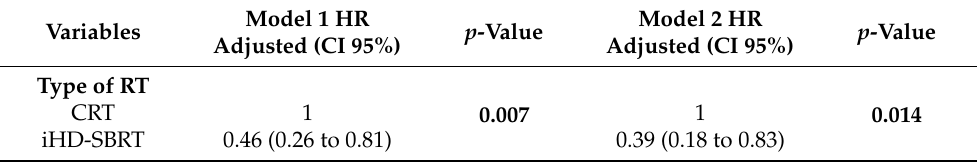
Table 4. Multivariate Cox regression analyses ( n =